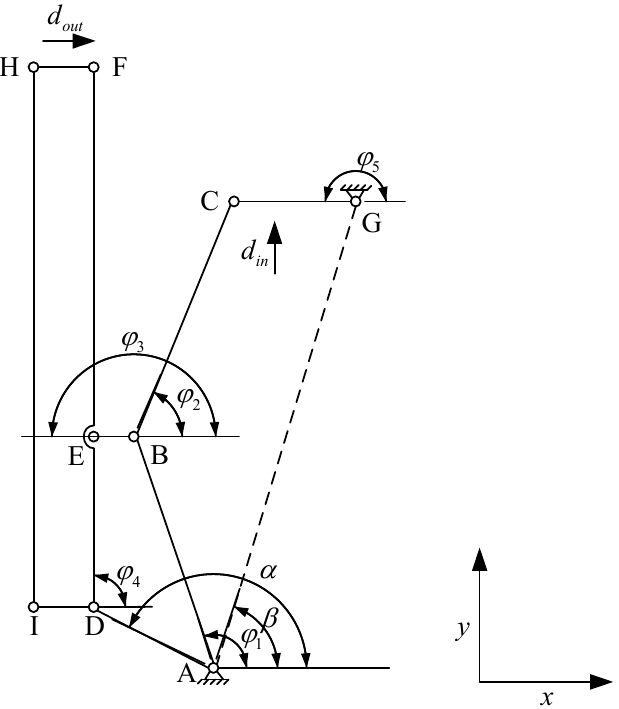
Figure 3. Pseudorigid ‐ body model of the three ‐ stage amplification mechanism.